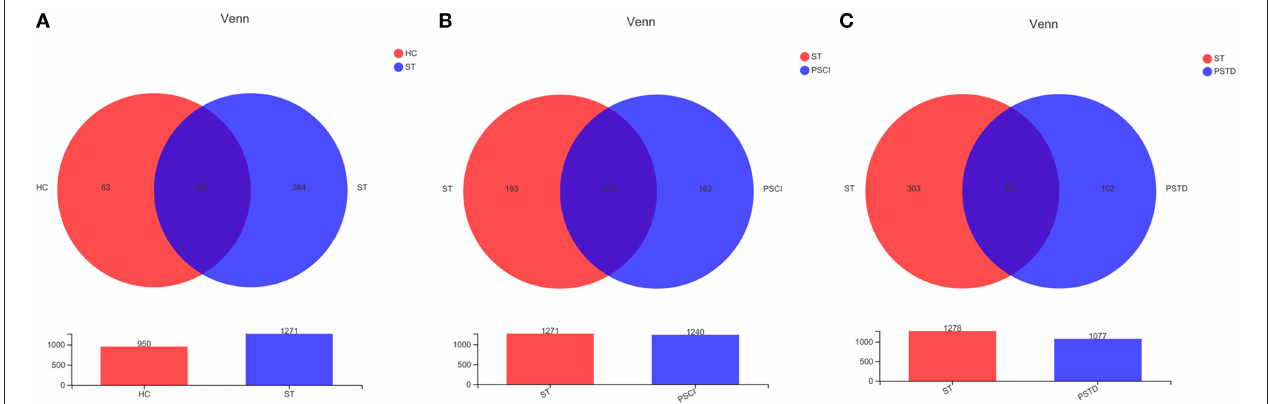
FIGURE 3 | Venn diagrams of ST and HC groups (A) , PSCI and ST groups (B) , PSTD and ST groups (C) .